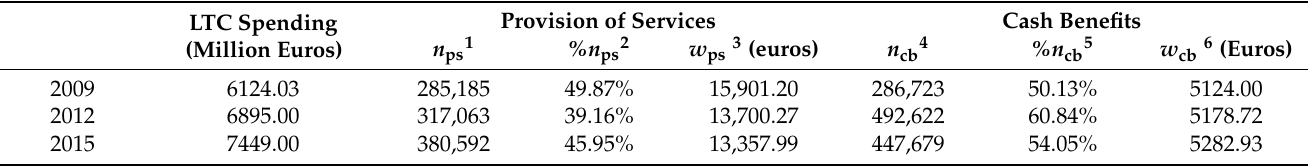
Table 1. Estimation of LTC spending by type of benefit.